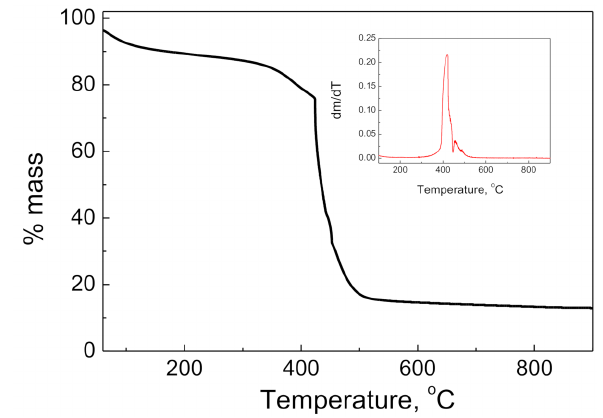
Figure 4. TGA curve of Na–BC. Inset: differential TGA